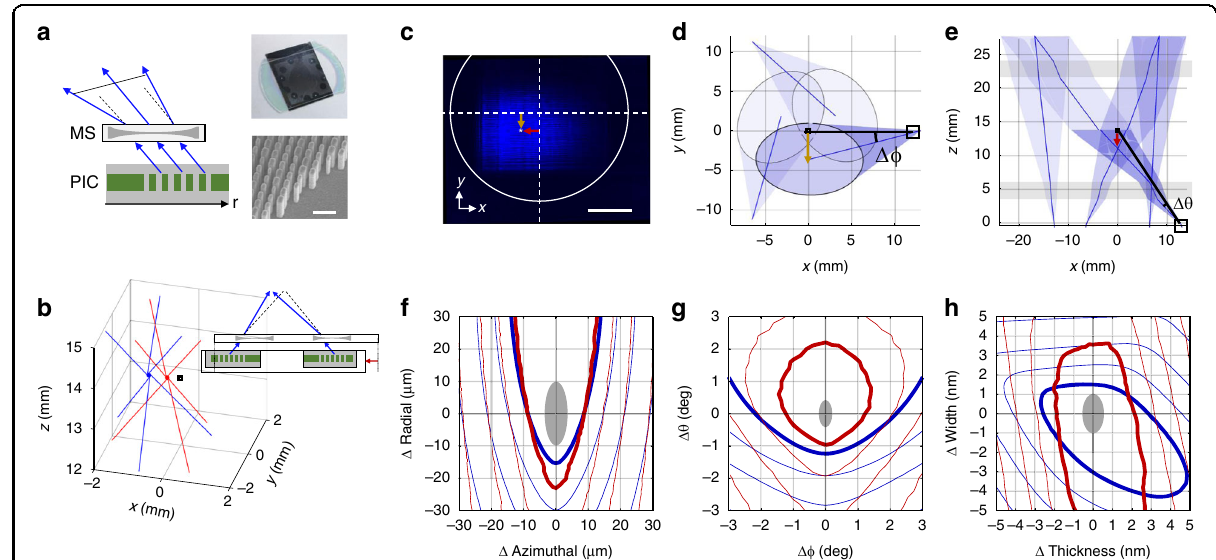
Fig. 5 Misalignment analysis of the MOT beams. a Diagram of PIC and MS alignment. The insets show a picture of the bonded device (top) and an SEM image of MS nanopillars (bottom, scale bar is 500 nm). b Simulation of beam misalignment due to a translational offset of 10 µm. Lines correspond to the axes of the six beams for the 461 nm (blue) and 689 nm (red) MOTs. The black point marks the MOT center for a perfectly aligned system. c Image of a blue beam at the height of the MS with an overlay depicting misalignment to the MS (centered at white crosshairs). The red arrow indicates a -40 µm radial misalignment, while the yellow arrow indicates a clockwise 40 µm azimuthal misalignment. Scale bar is 100 µm. d Simulated top view of the three blue 45° beams with a 40 µm clockwise azimuthal misalignment for illustration. The yellow arrow highlights the beam shift at the MOT center. e Simulated side view of all blue beams with a -40 µm radial misalignment. The red arrow highlights the beam shift at the MOT center. Gray regions depict the glass windows for a simulated vacuum chamber. Black squares highlight the location of the beam whose example offset is shown in ( c ). f Normalized beam overlap volume as a function of radial and azimuthal position misalignment between the PIC and MS emitter elements for the 461 nm (blue) and 689 nm (red) MOTs. g Normalized beam overlap volume as a function of angular misalignment. h Normalized beam overlap volume as a function of device fabrication imprecision. Contour spacings are 20 % with the 80 % contour bolded in ( f – h ). Gray regions in ( f – g ) correspond to typical experimental misalignments and the corresponding estimated fabrication imprecision ( h